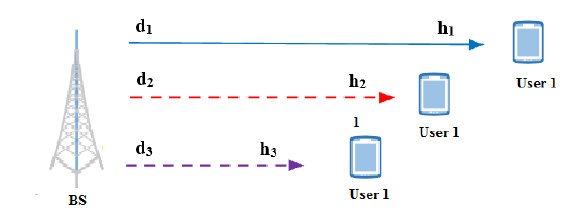
Figure 4. Wireless network consisting of one user U signals. NOMA with different